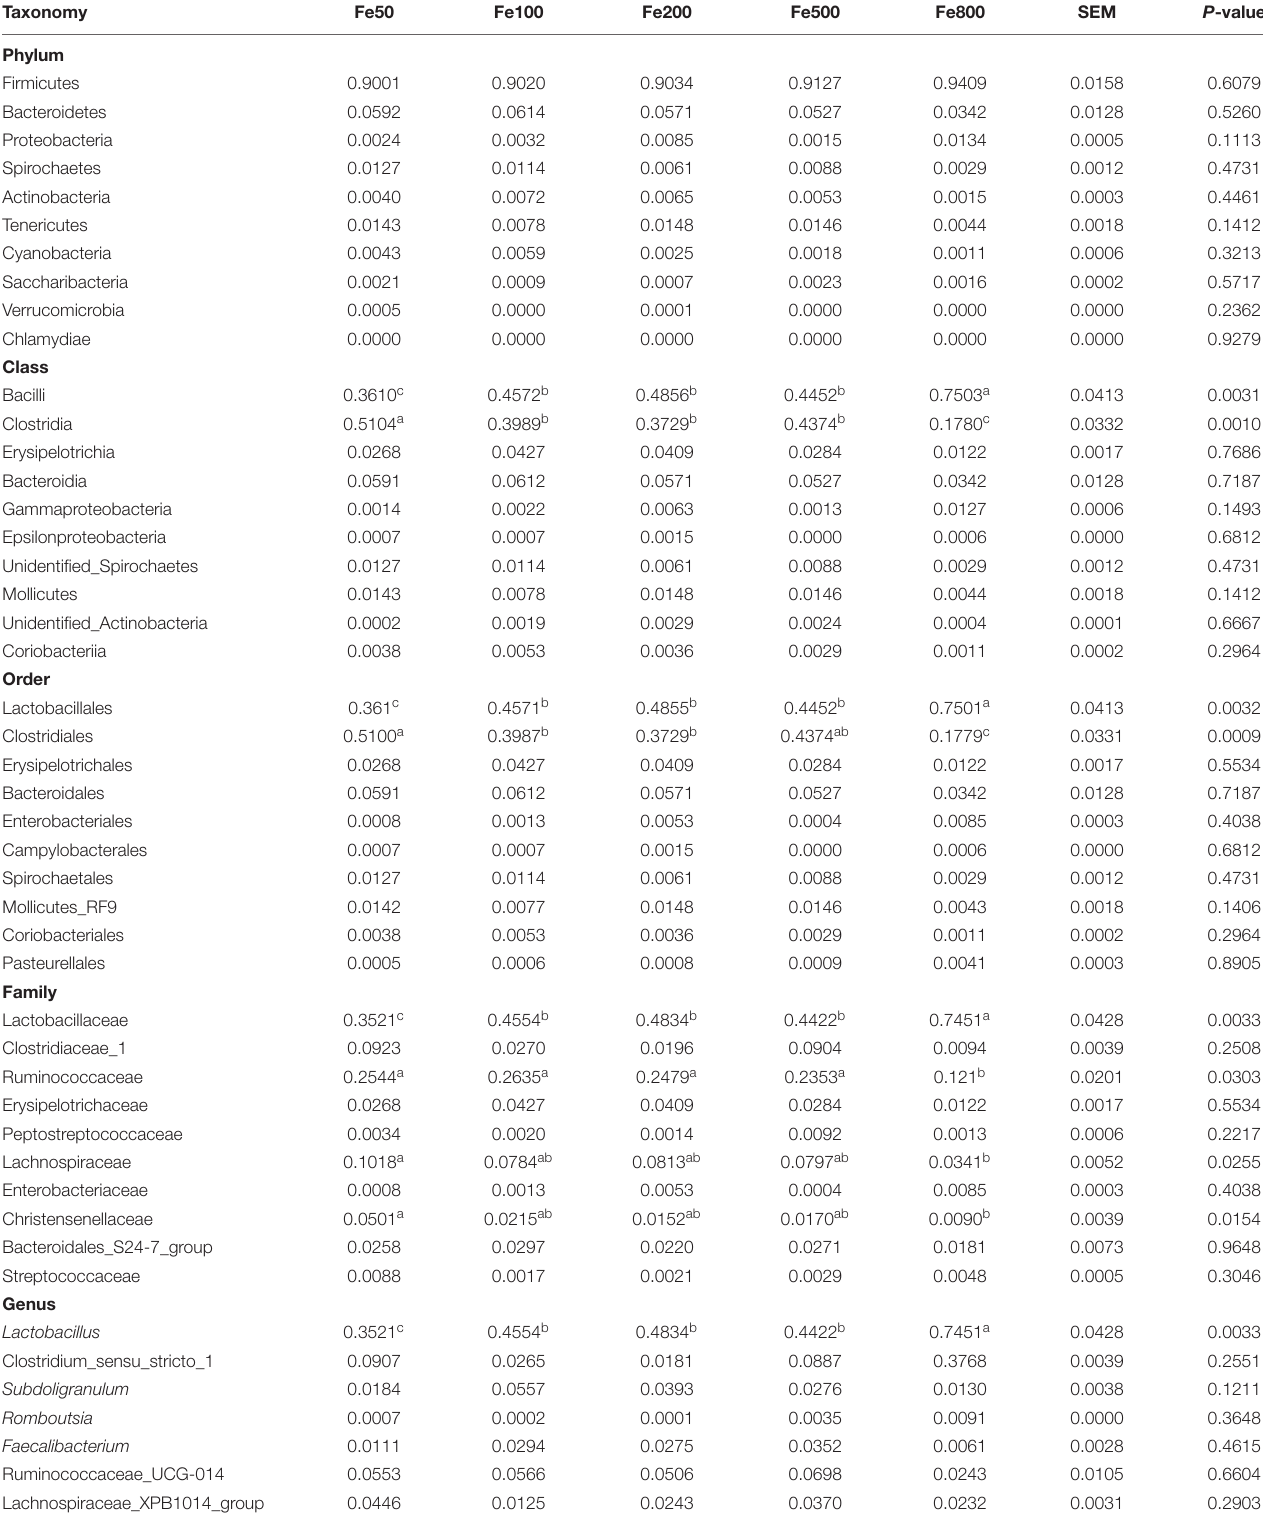
TABLE 2 | The top 10 taxa at the phylum, class, order, family, and genus level of colonic